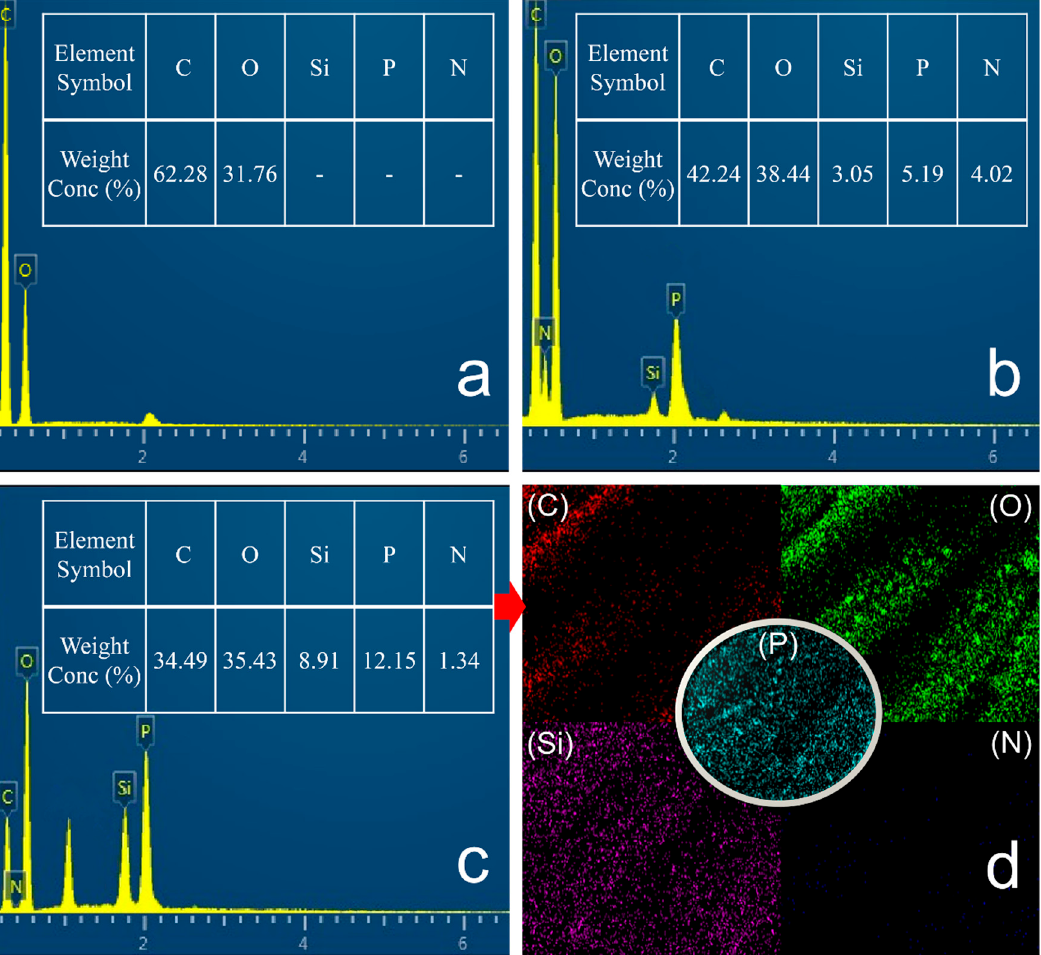
Figure 7. The main elements composition of the untreated cotton fabrics ( a ), treated cotton fabrics ( b ), treated cotton fabrics after combustion ( c , d ). ( d ) Corresponding EDS elements mapping images of treated cotton fabrics after combustion (C refers carbon, O denotes oxygen, Si refers silicon, P denotes phosphorus, and N refers nitrogen).